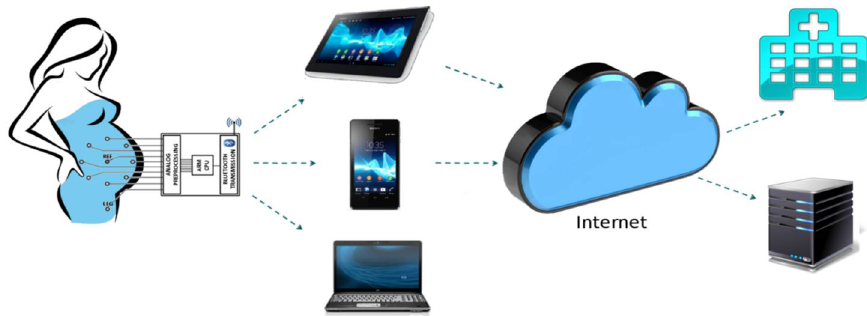
Figure 1. The Functional Diagram of the Telefetalcare System.